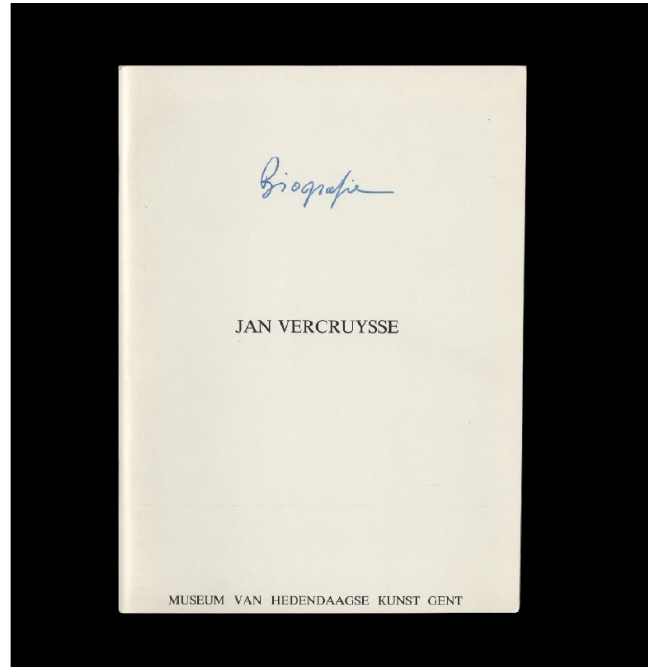
Figure 6. On the cover of a copy of the catalogue of his one-man show at the Museum of Contem- porary Art in Ghent in 1982, Jan Vercruysse wrote the word “Biografie” with a blue fountain pen. (Brussels: Jan Vercruysse Foundation). (Reprinted with permission from Jan Vercruysse